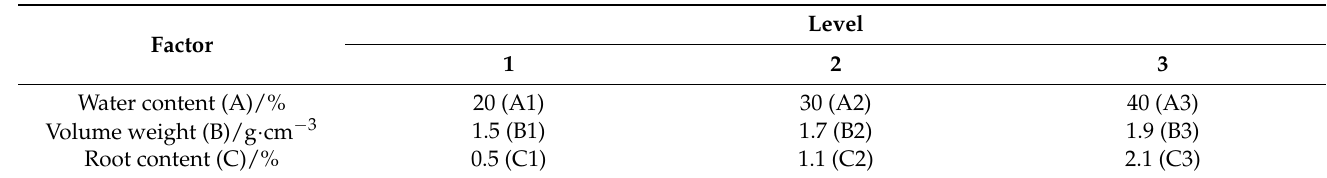
Table 2. Level table of testing factors for the mechanical characteristics of rice straw.